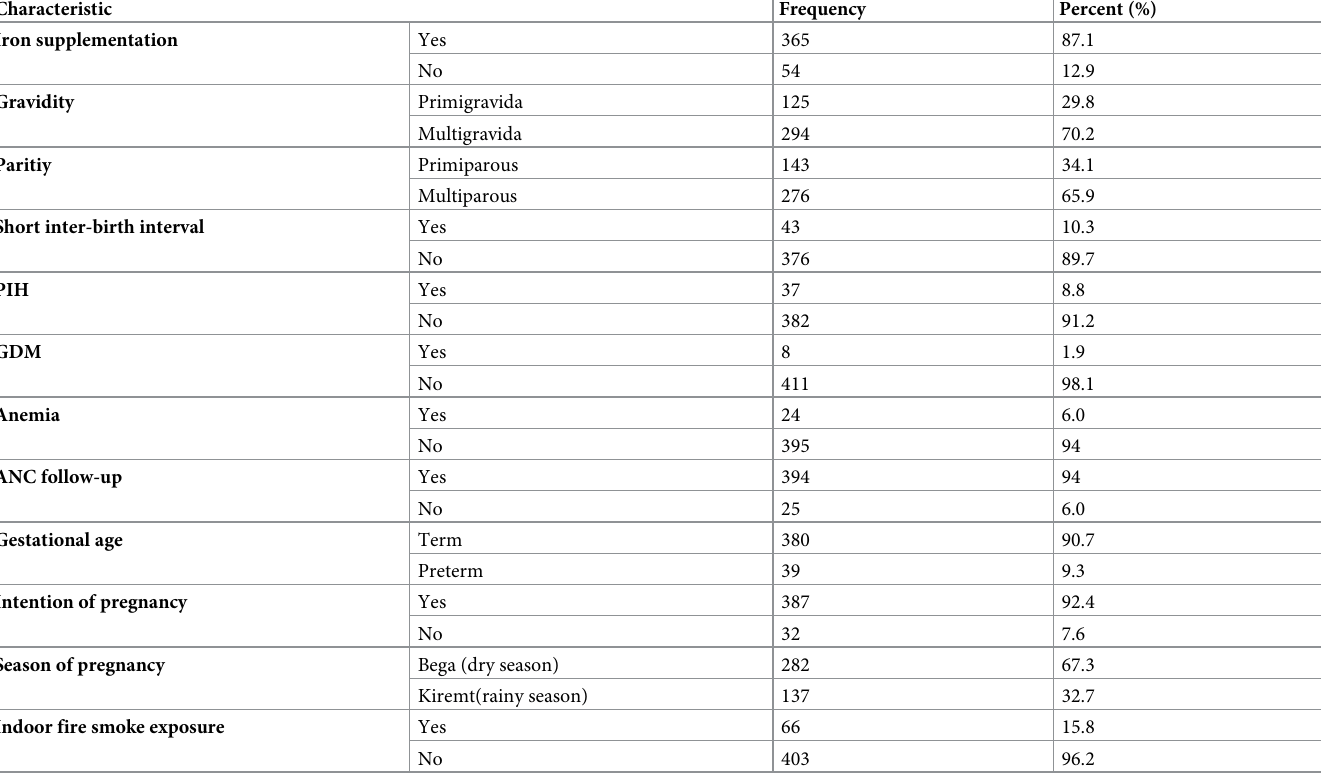
Table 2. Maternal and environmental characteristics among newborns delivered at the University of Gondar Comprehensive Specialized Referral Hospital, North- west Ethiopia, 2020. Characteristic